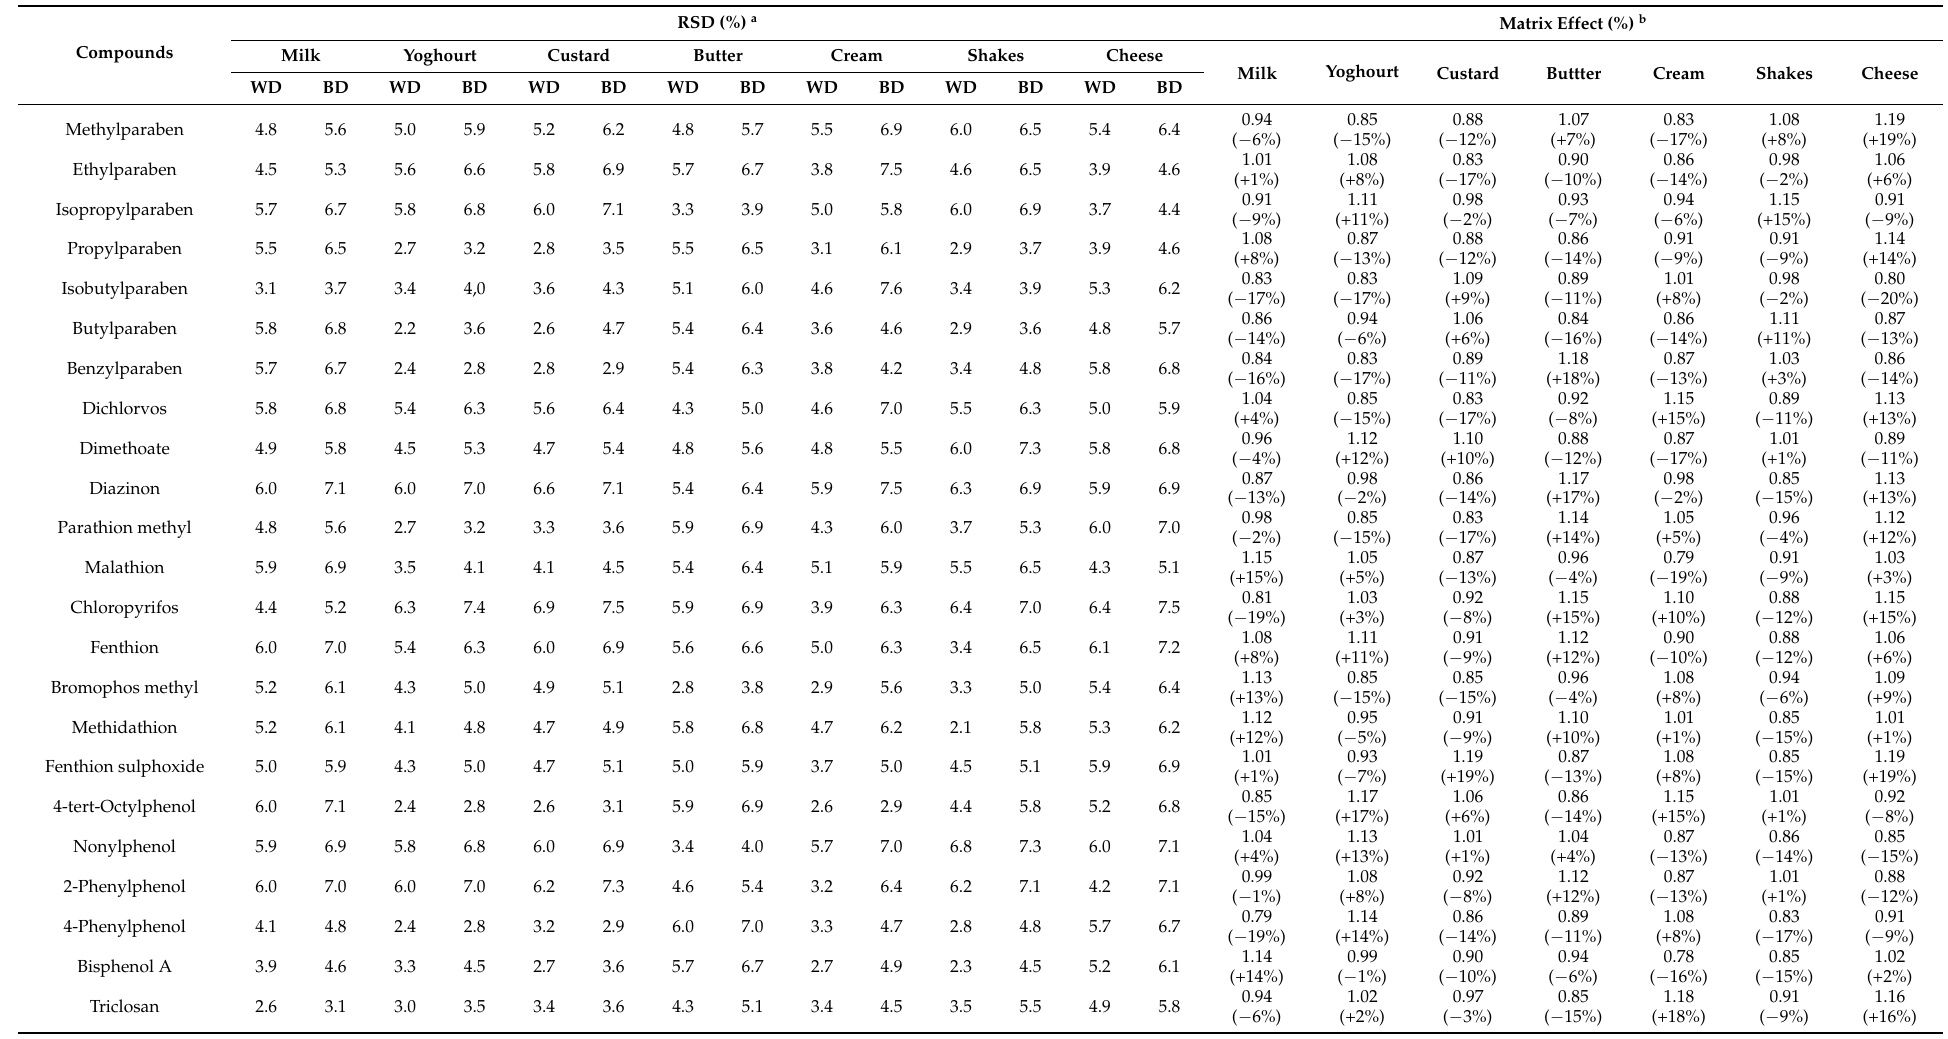
Table 2. Performance of the sample treatment procedure in terms of precision as relative standard deviation (RSD, %) and matrix